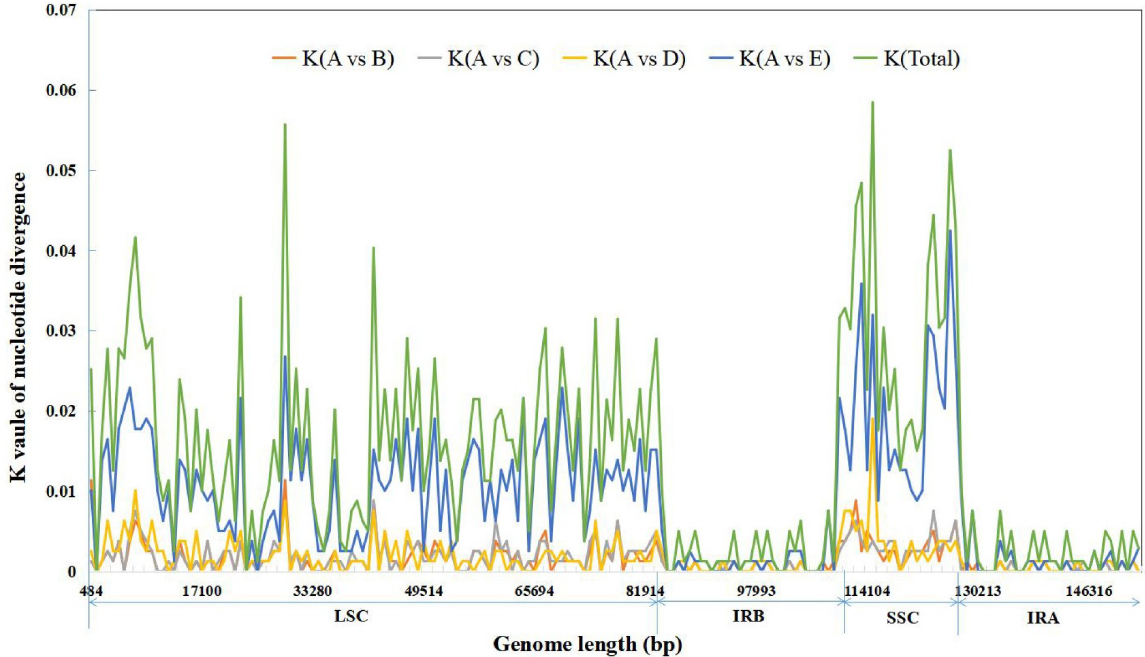
Fig 3. Sliding window analysis of five complete Isodon chloroplast genomes. Window length: 800 bp; step size: 200 bp. X-axis: nucleotide positions in the chloroplast genomes. Y-axis: K values of nucleotide diversity. A: I . rubescens from Lushan, Henan province ( IR-L ), B: I . rubescens (MW018469.1) from Xianyang, Shaanxi Province ( IR-X ), C: I . rubescens (MW376483.1) from Jiyuan, Henan Province ( IR-J ), D: I . serra (MT317099.1), E: I . lophanthoides (MT317098.1). Total: the total nucleotide diversity values for the A vs. B, A vs. C, A vs. D, and A vs. E